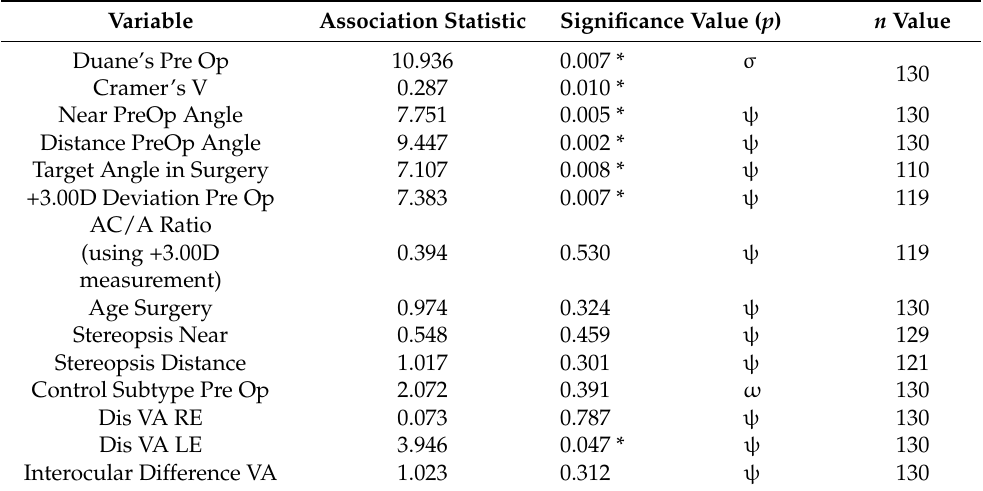
Table 4. The association between surgical outcome and preoperative